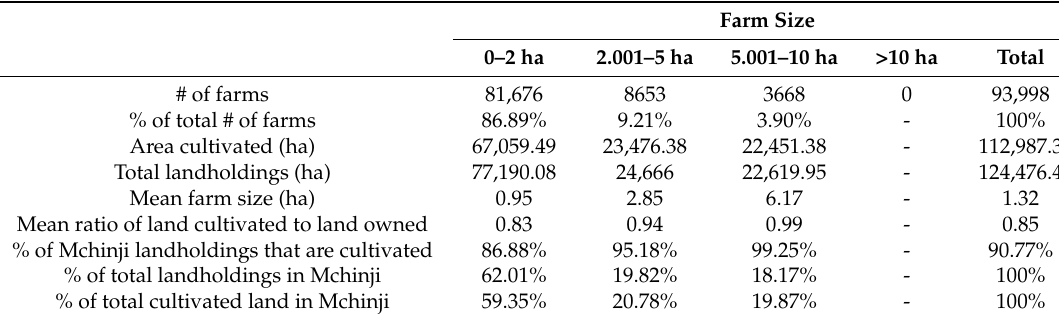
Table A3. Landholdings and area cultivated, by farm size in Mchinji district. Source: